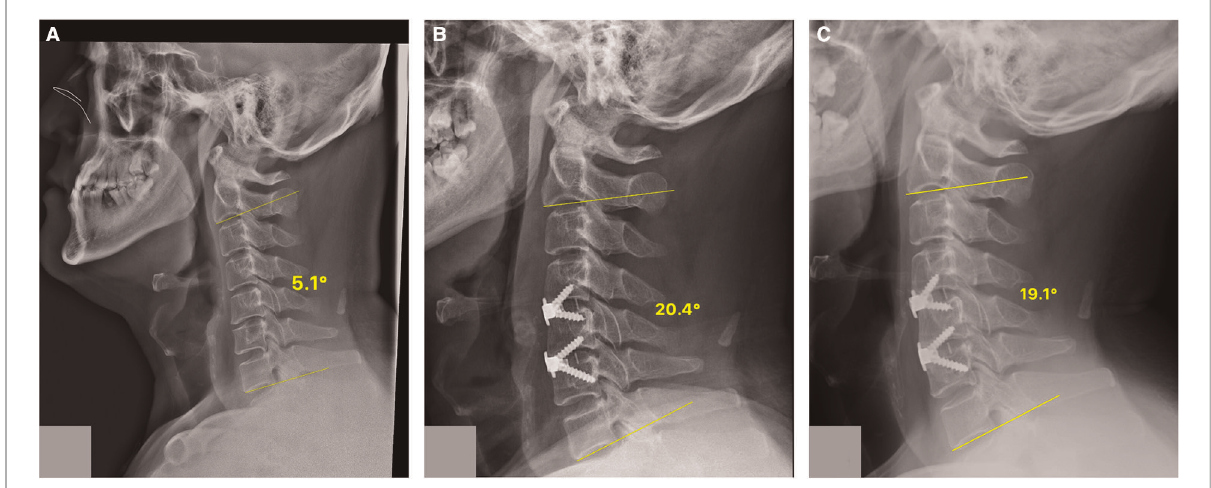
FIGURE 1 A case of the ZP group. Cervical lateral radiographs of a 47-year-old woman from the ZP cage group showing the C2 – C7 Cobb angle at different time points. ( A ) 5.1° preoperatively; ( B ) 20.4° postoperatively; ( C ) 19.1° at the fi nal follow-up. ZP, zero-pro fi le